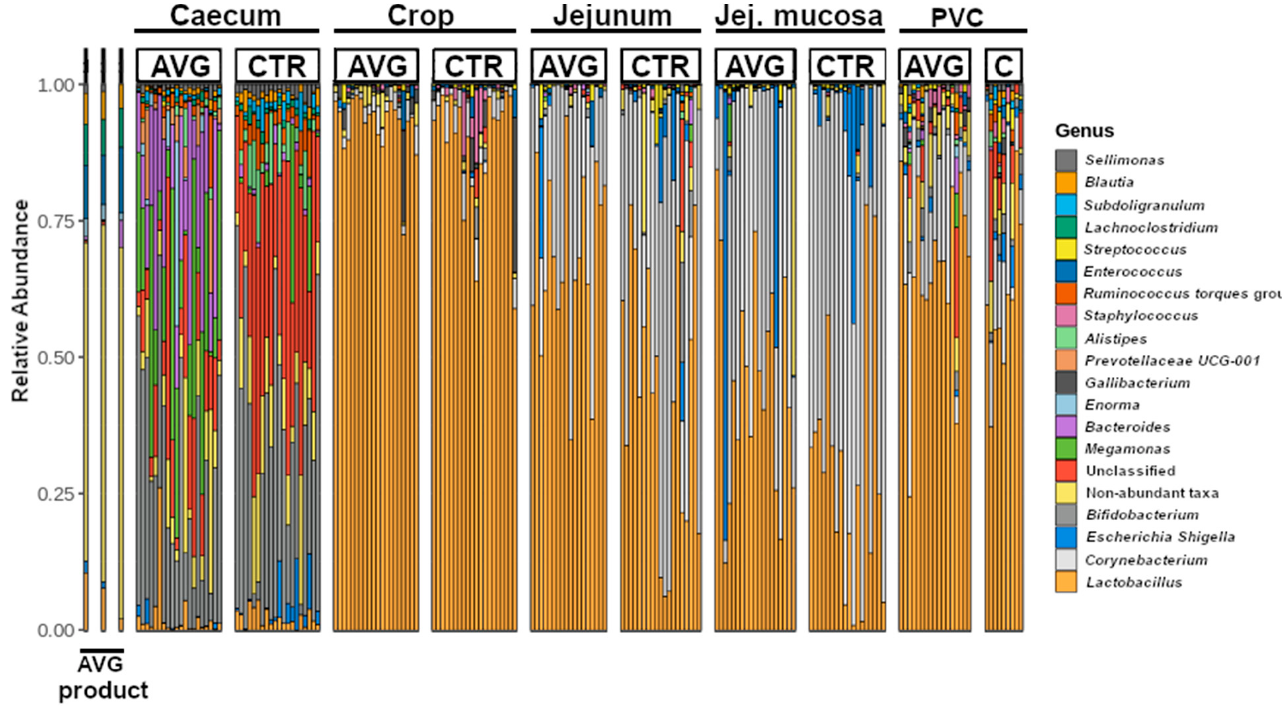
Figure 2. Genus-level relative abundance, including the twenty most abundant genera. The plot shows only known genera, while all unknown and unclassified genera from all families were binned into “Unclassified”. Jej.mucosa = Jejunum mucosa, PVC = proventriculus.